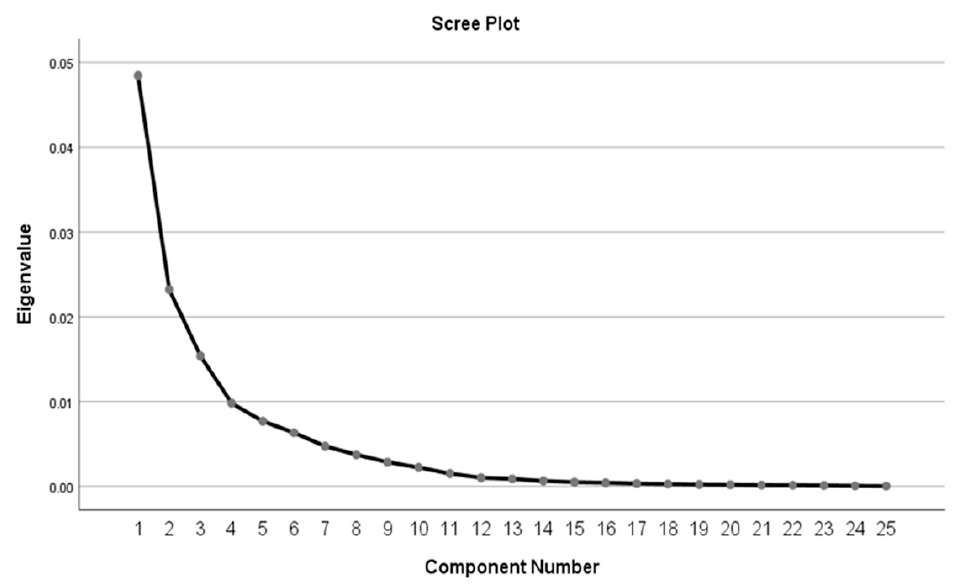
Figure 1. Scree plot showing the eigen values of the principal components which are representative of the nutrient patterns.